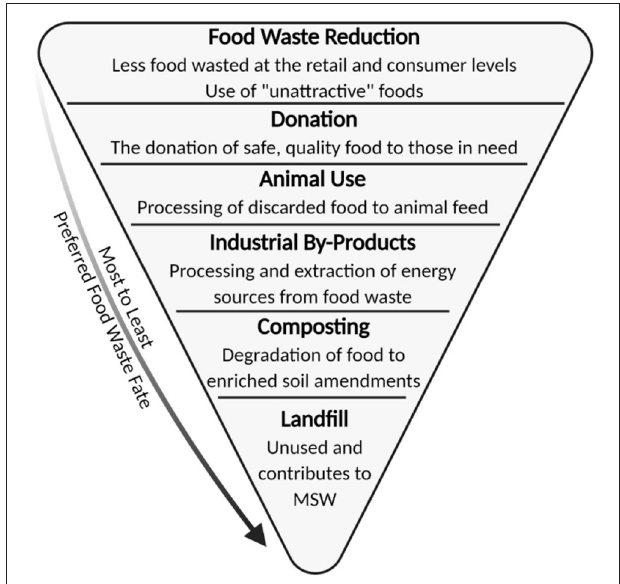
FIGURE 1 | The fate of food waste. Adapted from the U.S. Environmental Protection Agency (EPA) (2017b). The ultimate endpoint of food waste from the best- to worst-case scenario. Created with BioRender.com. MSW, municipal solid waste.